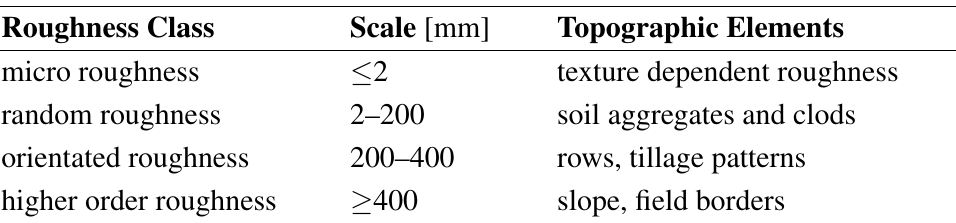
Table 1. Roughness classification after